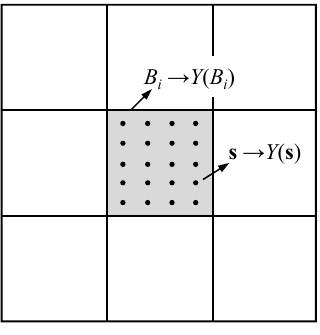
Figure 4. Point and block data, such that for spatial data, Y(B i ) represents the average of the point data within the